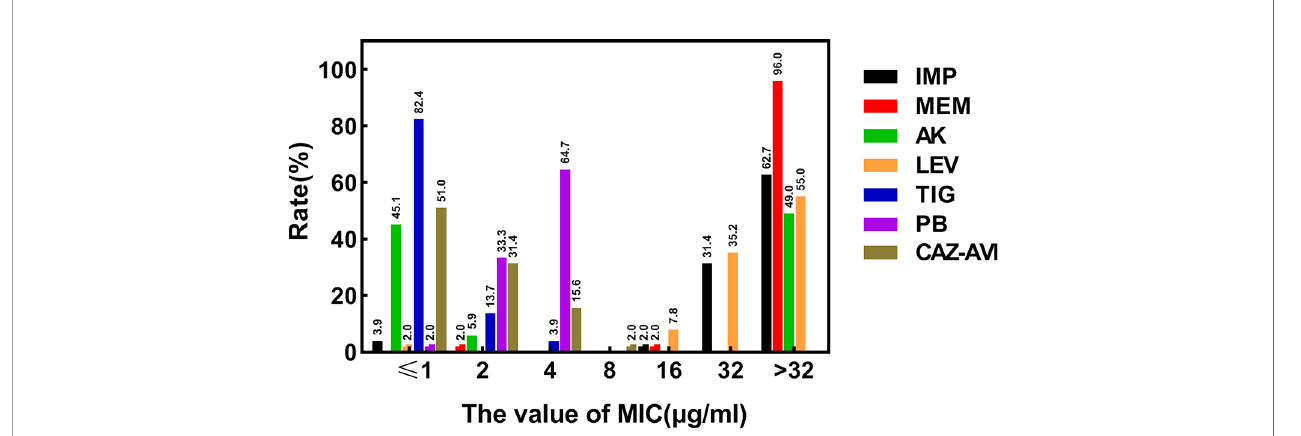
FIGURE 3 | Distribution of MIC values of different types of antibiotics determined by broth micro-dilution method. MIC, the minimal inhibitory concentration; µg/ml, micrograms per milliliter; IMP, Imipenem; MEM, Meropenem; LEV, Levo fl oxacin; AK, Amikacin; PB, Polymyxin B; TIG, Tigecycline; CAZ – AVI, ceftazidime